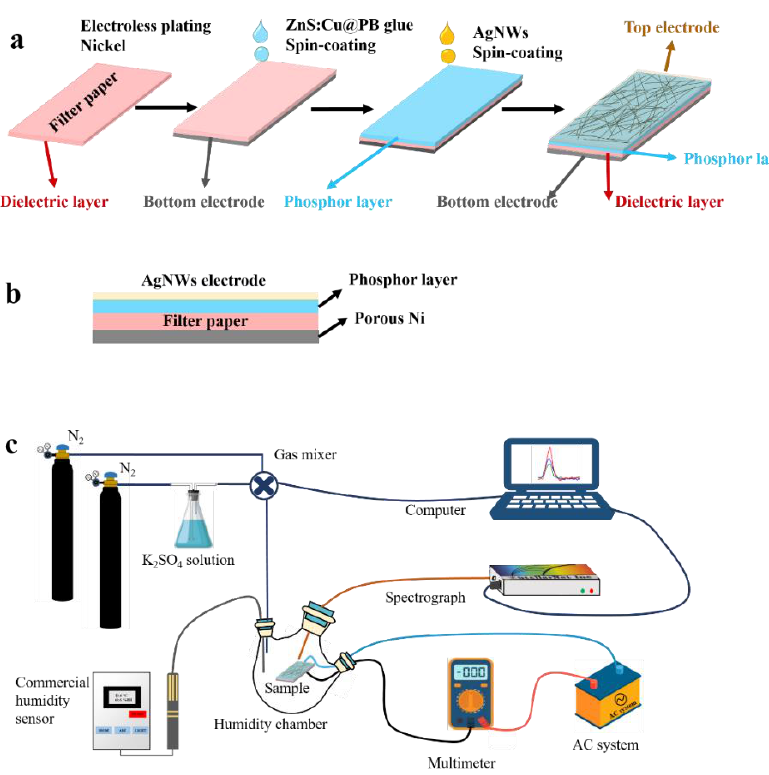
Figure 1. ( a ) Flow chart for paper-based alternating current electroluminescent devices (ACELs) fabrication. ( b ) Schematic image of the device. ( c ) Testing equipment used for optical and electrical characterization of the electroluminescent (EL) devices.